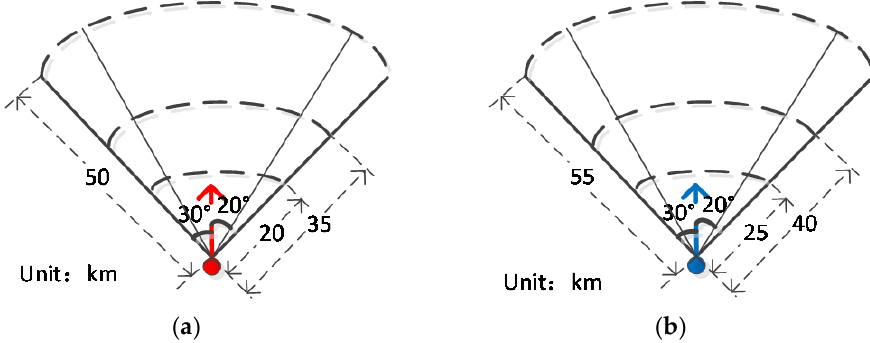
Figure 3. The missile attack area of both sides. ( a ) Native radar; ( b ) Enemy radar.